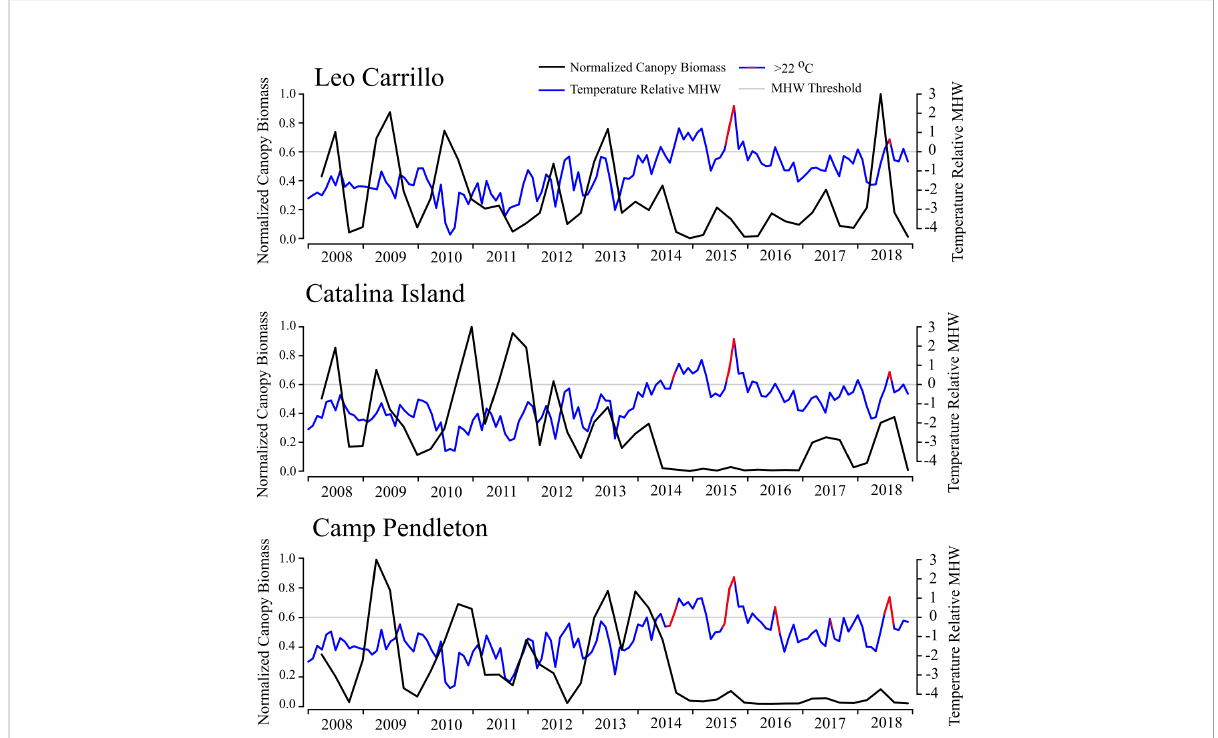
FIGURE 3 Normalized Macrocystis pyrifera biomass (30 km radius buffer) and Marine Heatwave (MHW) events from 2008 to 2018/19 for Leo Carrillo, Catalina Island (averaged over different locations), and Carlsbad (averaged over 2008 and 2018/19 locations). Kelp biomass is shown quarterly and normalized by the quarter of maximum biomass from 2008 to 2018/19 (black). Temperatures (Blue) are shown as monthly means relative to the MHW threshold (gray). Shown in red are periods when the mean monthly temperature exceeded a conservative species tolerance threshold of 22 °C.